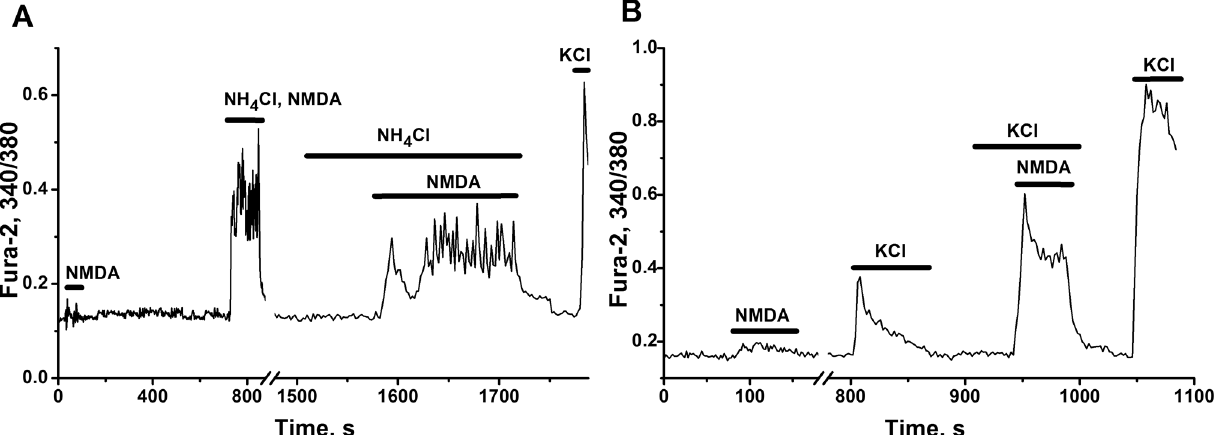
Fig 7. Synergistic action of ammonium ions and NMDA on changes in calcium concentrations in immature neuronal cells. Neuronal cultures 5 and 7 DIV. All other abbreviations and descriptions as on Fig 1. Gaps in the traces represent pauses in data recordings. (A) Combined synergistic action of NH 4 Cl (4 mM) and NMDA (10 μ M) on cellular Ca 2+ level, both of each separately cannot evoke Ca 2+ signal and activate the cell. Culture 5 DIV. N = 66. (B) Neuronal Ca 2+ responses to separate and combined action of NMDA (20 μ M) and KCl (5 mM). Culture 7 DIV. N = 72.